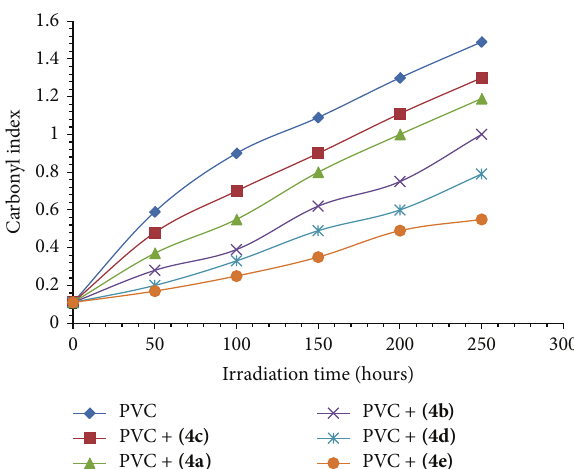
Figure 3: The relationship between the carbonyl index and irradi- ation time for PVC films (30 𝜇 m thickness) containing each of 4a– e (0.5% by weight) compared to PVC without additive (blank).